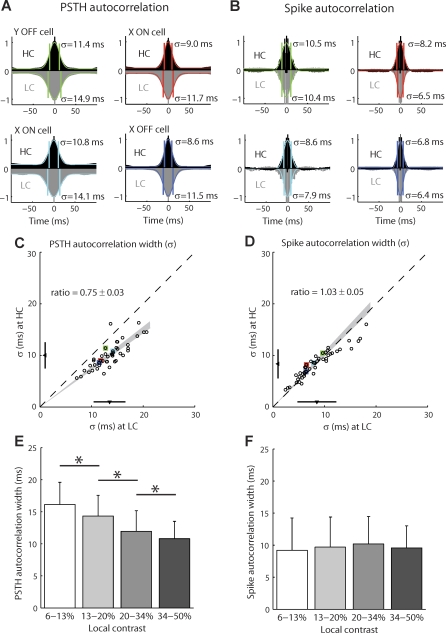
Firing Event Timing Precision Changes with Contrast, but Spike Timing within Events Does Not(A and B) Examples of PSTH autocorrelation (A) and spike autocorrelation (B) for four typical cat LGN cells. In each plot, the temporal width of the autocorrelation function is measured as the standard deviation of the Gaussian function that best fits it in the least-mean-square sense, both at HC (top half of each plot) and LC (bottom half).(C) Temporal width of PSTH autocorrelation for all cells (n = 45). The dashed line is the unity line. The shaded area indicates the 95% confidence estimate of the mean HC/LC ratio of the widths. The mean ± standard deviation are represented along each axis by an arrowhead and bar. The four cells illustrated in (A) and (B) are highlighted in the same colors in (C) and (D).(D) Temporal width of spike autocorrelation for all cells (n = 45). Same conventions as in (C).(E) Temporal width of PSTH autocorrelation for all cells at four levels of local contrast. Each bar represents the mean + 1 standard deviation (n = 45 cells) at the corresponding range of local contrast. Note that the error bars, which represent standard deviation, are not by themselves indicative of whether two distributions have significantly different means. Instead, we used asterisks to indicate that two means are statistically significantly different (paired t-test, p < 0.05).(F) Temporal width of spike autocorrelation for all cells (n = 45) at the same four levels of local contrast as in (E). Each bar represents the mean + 1 standard deviation.